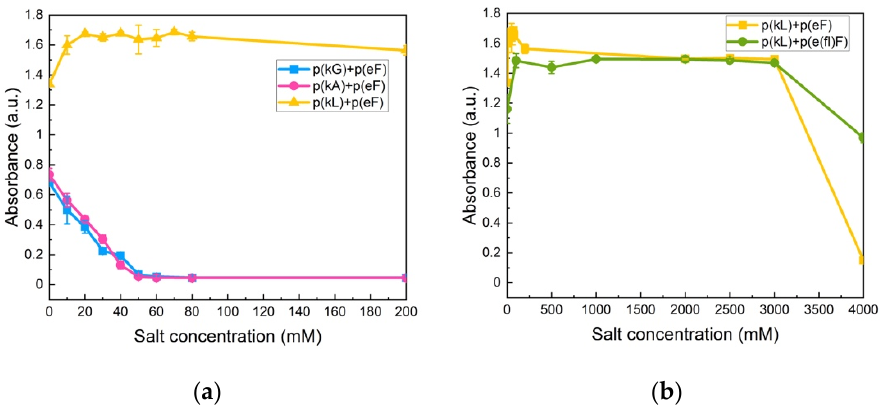
Figure 8. Turbidity measurements at varied NaCl concentrations: ( a ) p(kG), p(kA), and p(kL) sequences paired with p(eF); ( b ) p(kL) + p(eF) and p(kL) + p(e(fl)F). Complexes with p(kL) show high stability against salt. All sequence pairs were prepared at equal stoichiometry with a total concentration of 5 mM with respect to the monomer charge.